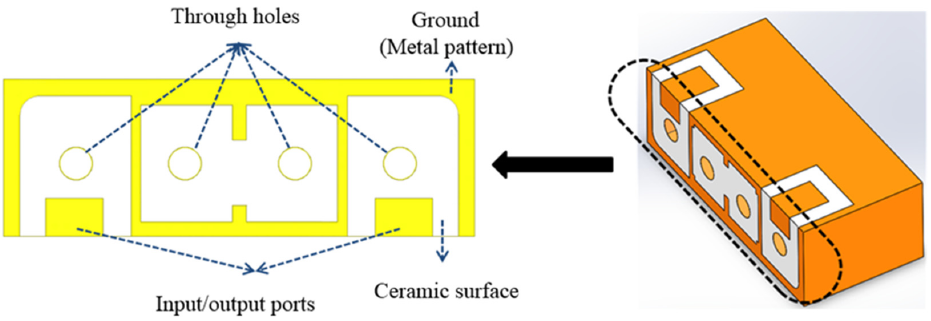
Figure 2. The microwave dielectric ceramic filter structure.